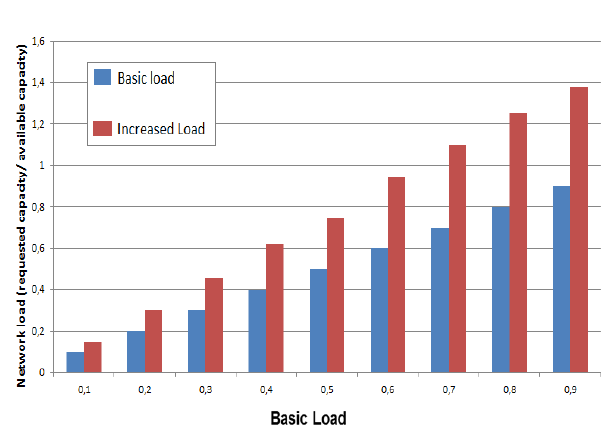
Figure 2: Network load versus basic and increased loads